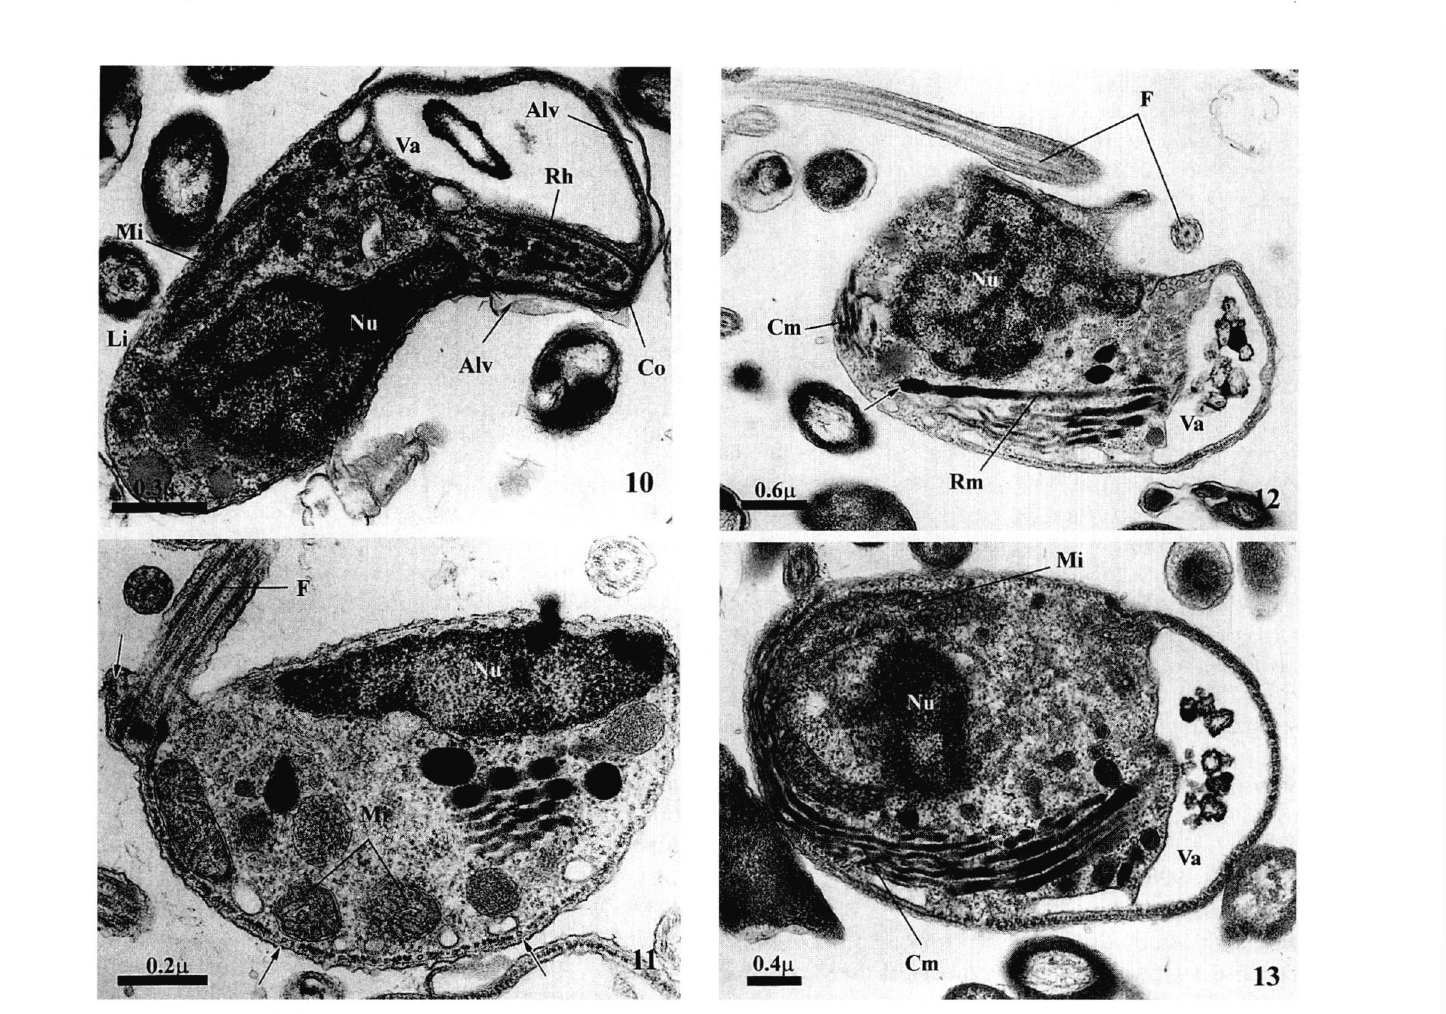
Fig. 10. - Longitudinal section of a mature zoospore showing vacuole (Va), alveoli (Alv), nucleus (Nu), mitochondrion (Mi), lipid- like bodies (Li), conoid (Co), and rhoptries (Rh). Fig. 11. - Transmission electron micrograph of a free zoospore sho­ wing subpellicular microtubules (arrows), several oval or round mito­ chondria (Mi), and the kinetosome of a flagellum (F).